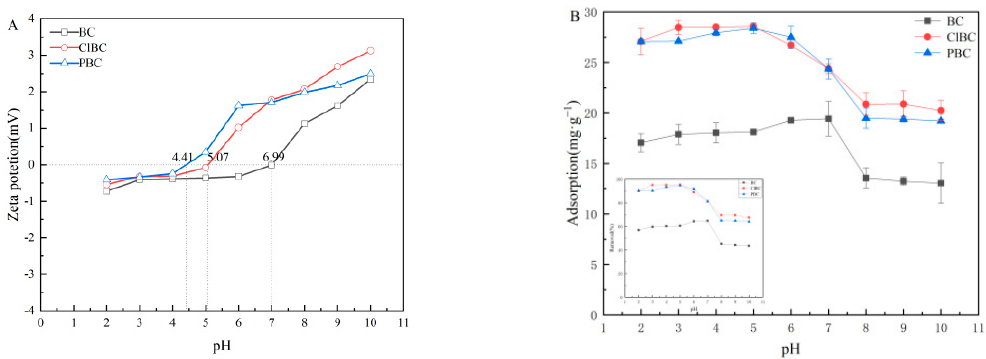
Figure 6. ( A ) Zeta potential of biochars; ( B ) influence of initial pH on adsorption.